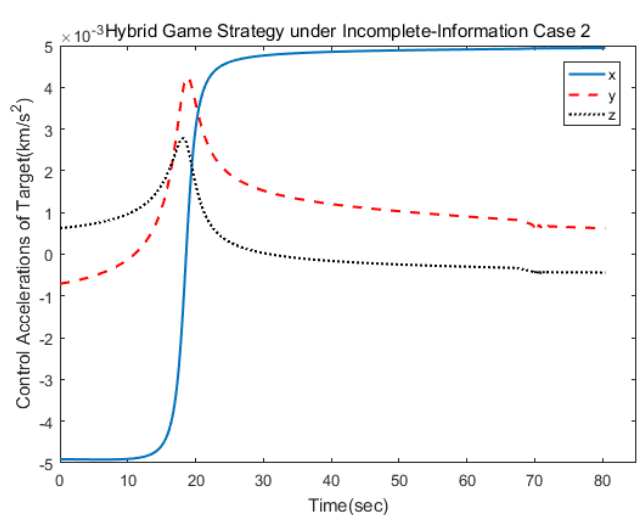
Figure 13. Control acceleration of the target.